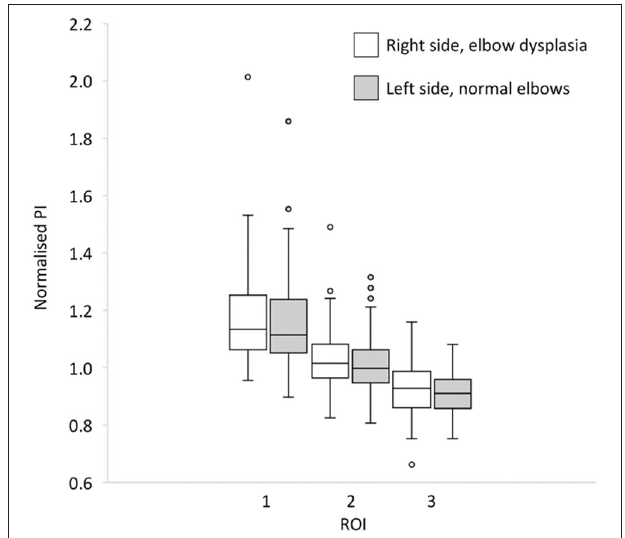
FIGURE 6 | Box-and-whisker plot for comparison between normalized pixel intensity of ulnar trochlear notch (UTN) right-side elbows with elbow dysplasia and contralateral left side normal elbows on regions of interest (ROIs) 1 (distal UTN), 2 (middle UTN), and 3 (caudal UTN) ( N = 60).